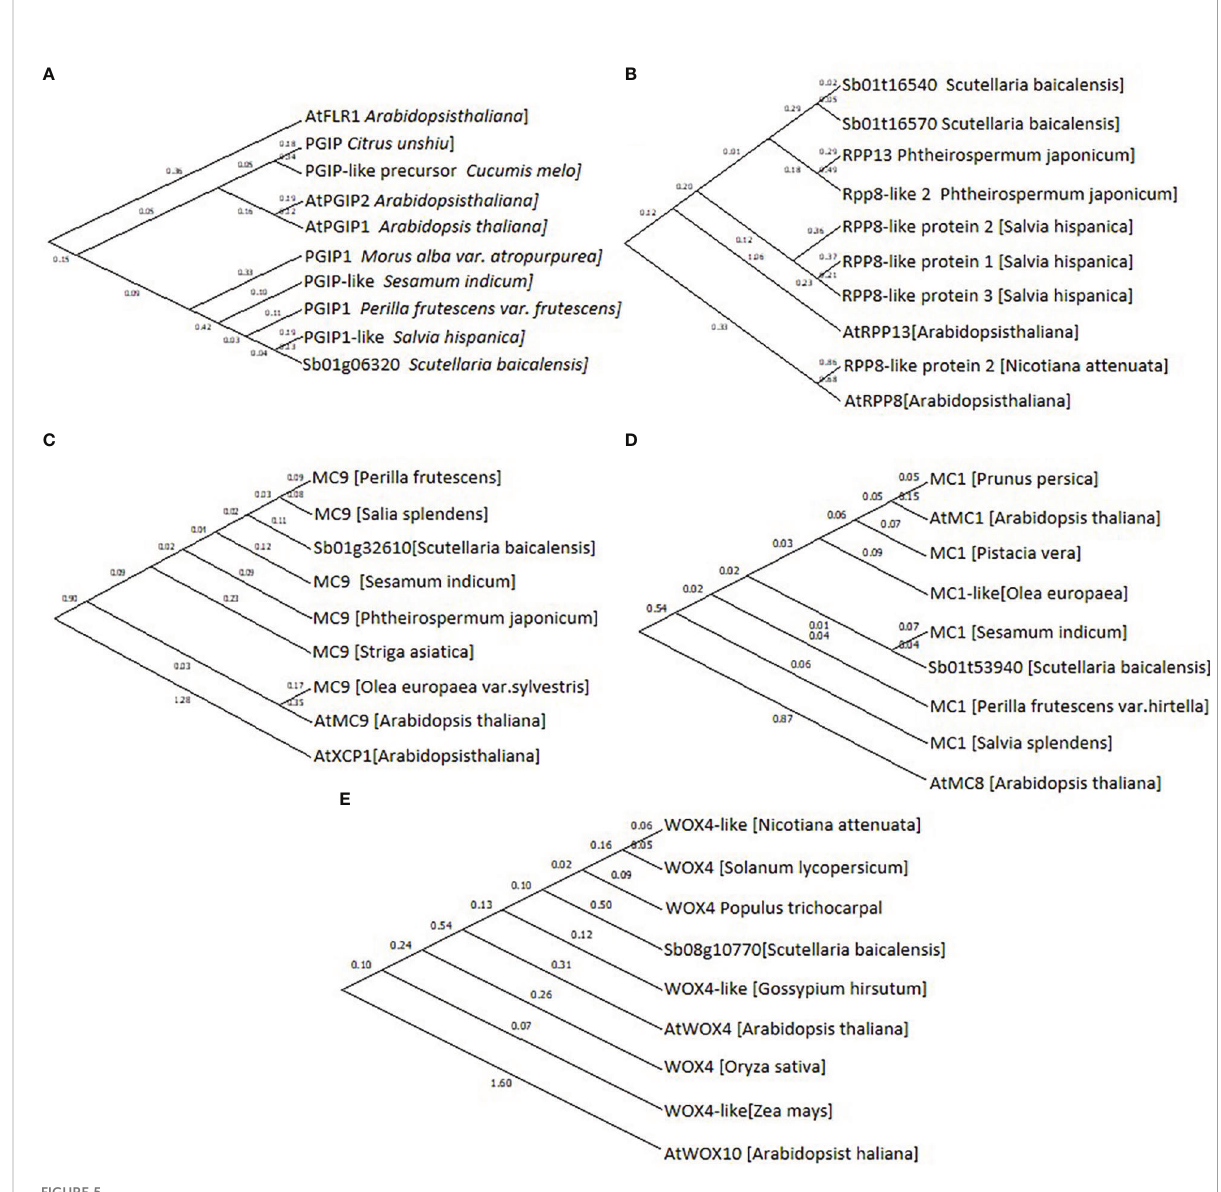
FIGURE 5 Phylogenetic tree of (A) , Sb01g06320; (B) , Sb01g16540 and Sb01g16570; (C) , Sb01g32610; (D) , Sb01g53940 and (E) , Sb08g10770. Maximum likelihood (ML) was used to construct this tree with 1000 replicate bootstrap